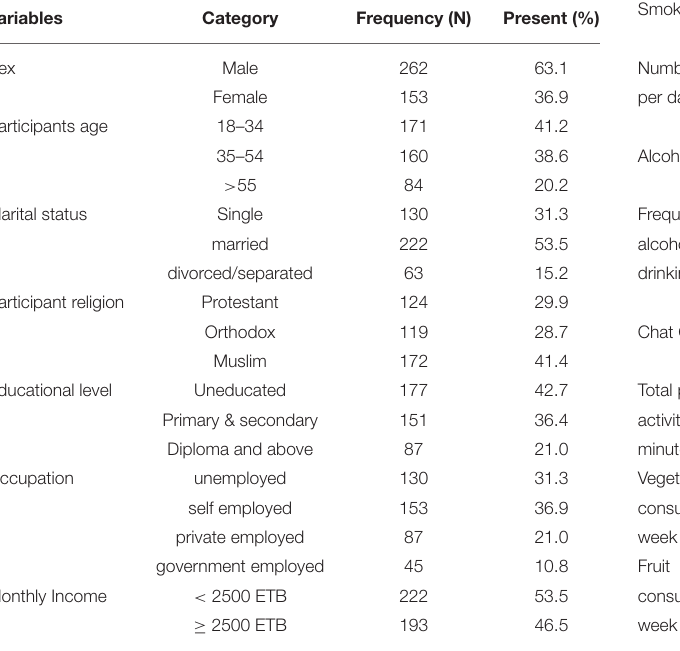
TABLE 1 | The socio-demographic and economic characteristics of the Menja community in Bench-Sheko zone Southwest Ethiopia, 2022, ( N = 415). Variables